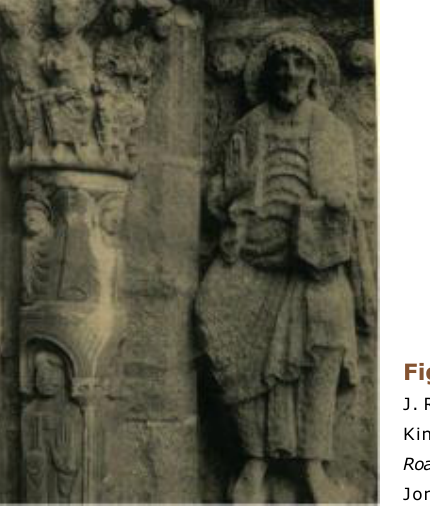
J. Roig, Apostles, Angels, St. Peter, an Apostle , from Arthur Kingsley Porter, Romanesque Sculpture of the Pilgrimage Roads , vol. 6, Castile, Asturias, Galicia (Boston: Marshall Jones Company, 1923), plate 688 (photo: author).